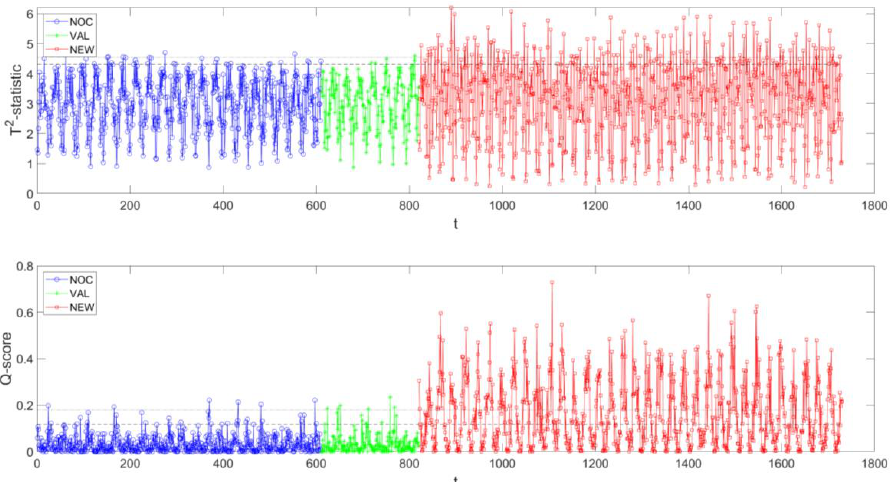
Figure 17. T 2 ( top ) and Q ( bottom ) process monitoring charts of simulated dataset using Method III,